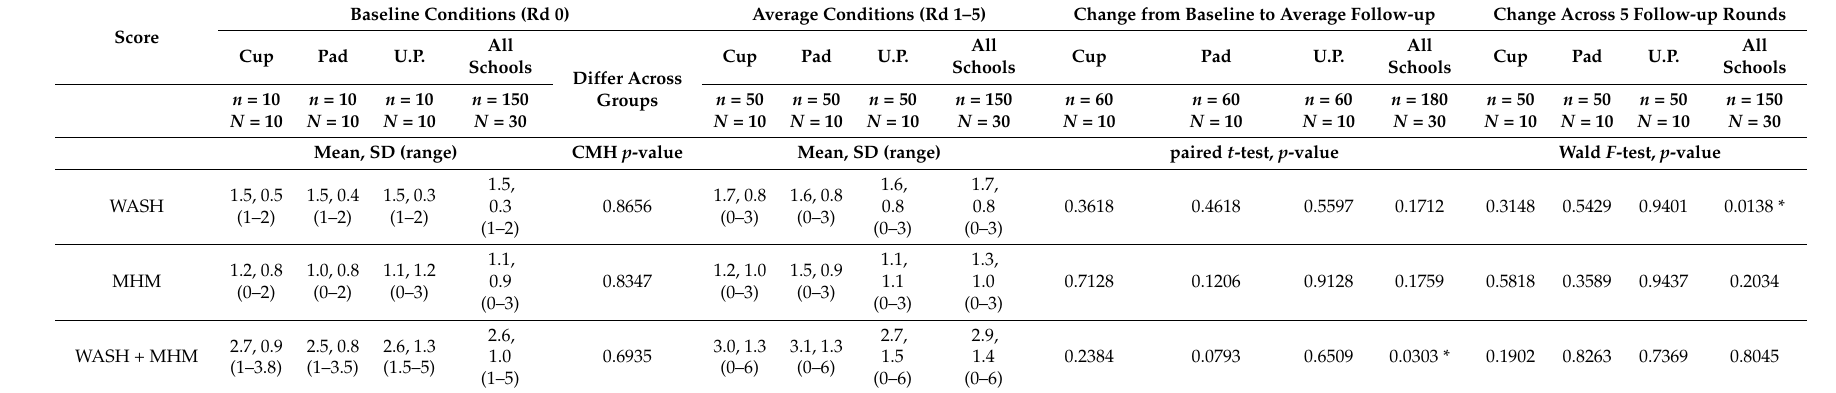
Table 4. Scores for water, sanitation, and hygiene (WASH), menstrual hygiene management (MHM), and WASH+MHM per treatment group in western Kenya,